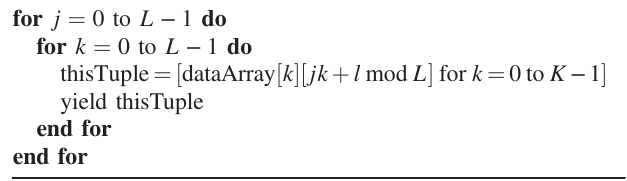
NEARLY OPTIMAL MEASUREMENT SCHEDULING FOR PARTIAL Algorithm 1. Iterate over symmetry-conserved 2-RDM Algorithm 2. parallelIterate:Iterateover K listsdataArray ½ 0 (cid:3) ; … ; dataArray ½ K − 1 (cid:3) of L elements, generating all pairs between elements in separate lists. Assumes K is less than the smallest factor of L .